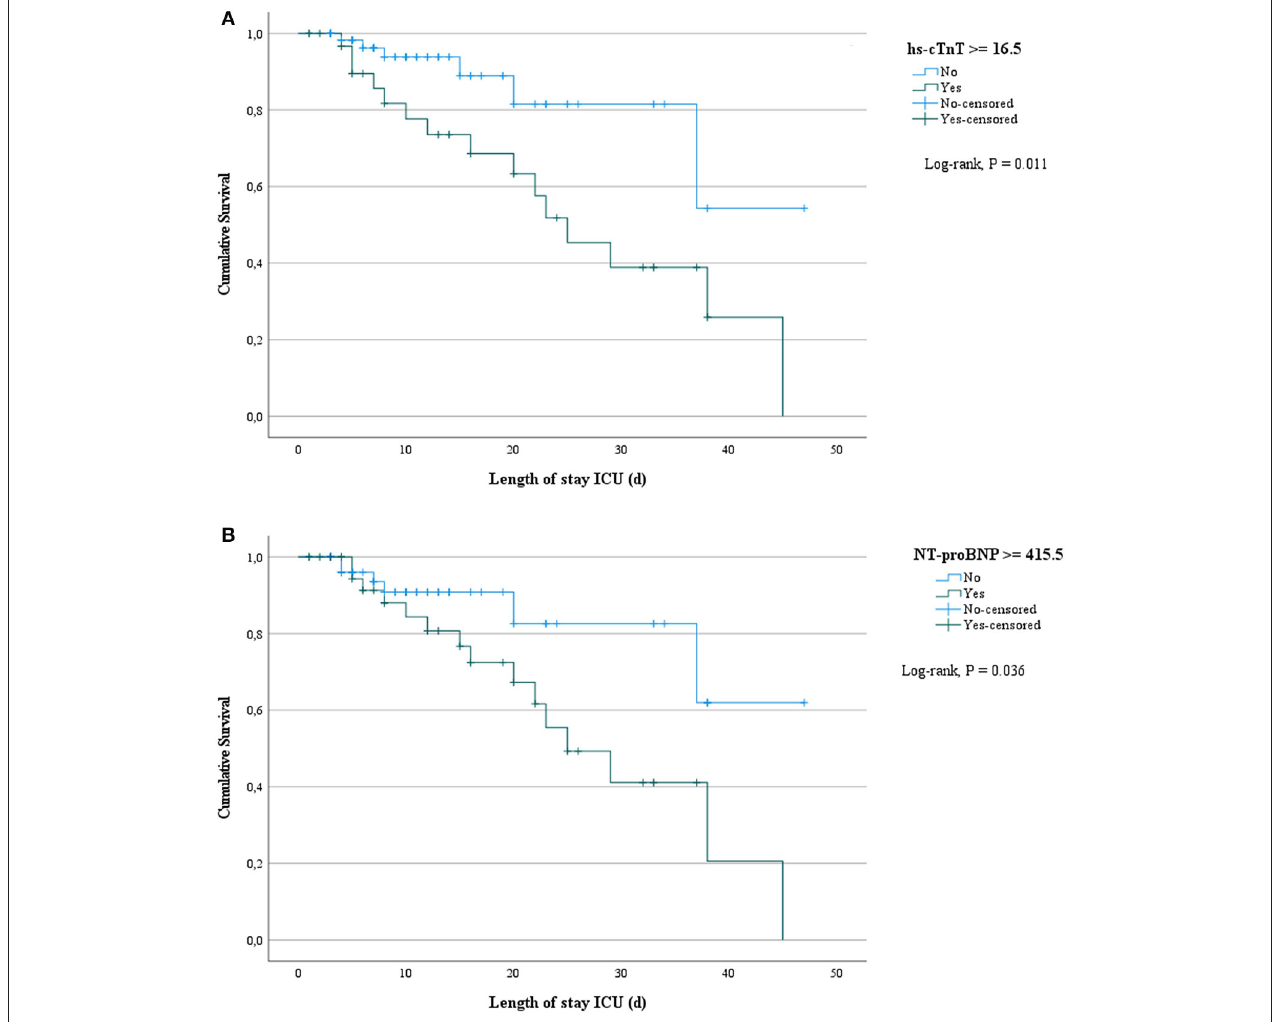
FIGURE 3 | Survival analysis based upon the level of hs-cTnT and NT-proBNP on admission to ICU. Survival analysis based upon both levels of high sensitive troponin T (A) and N-terminal pro-brain natriuretic peptide (B) on admission to ICU. hs-cTnT, high-sensitive troponin T; NT-proBNP, N-terminal pro-brain natriuretic peptide.